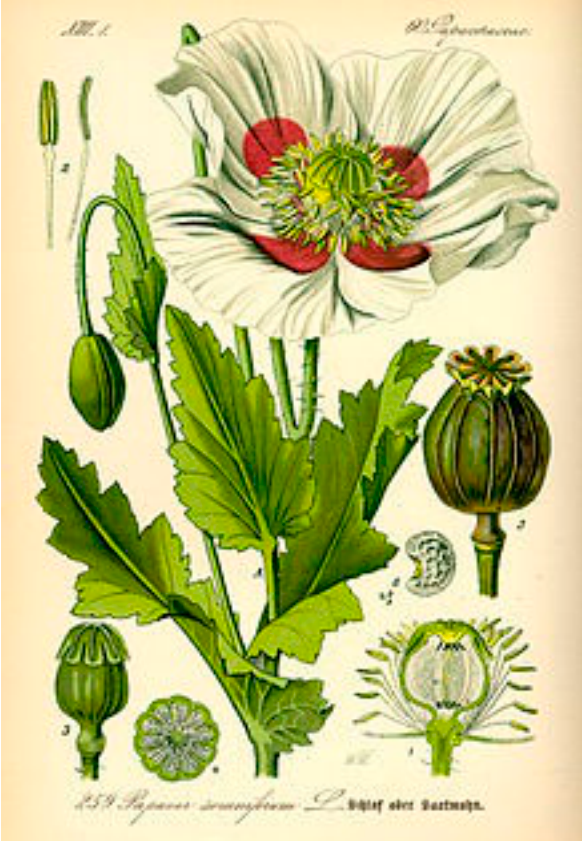
Figure 5. Papaver somniferum